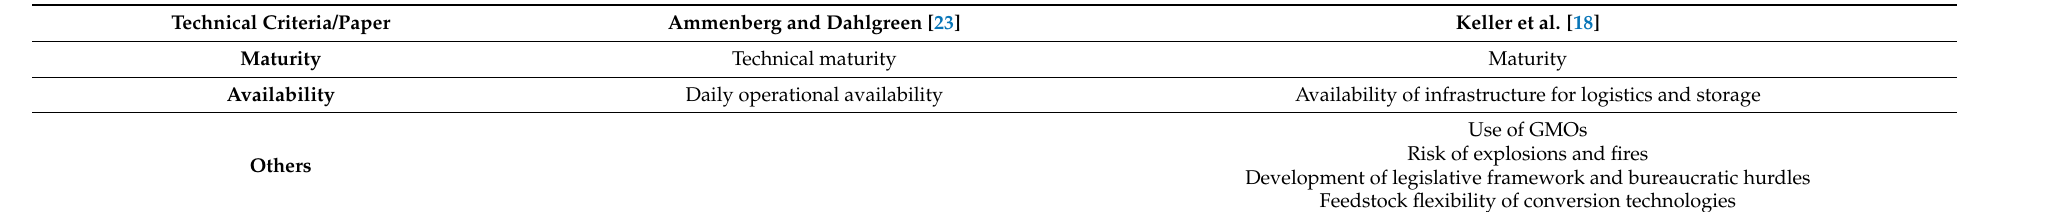
Table A4. Technical criteria used in LCSA-related